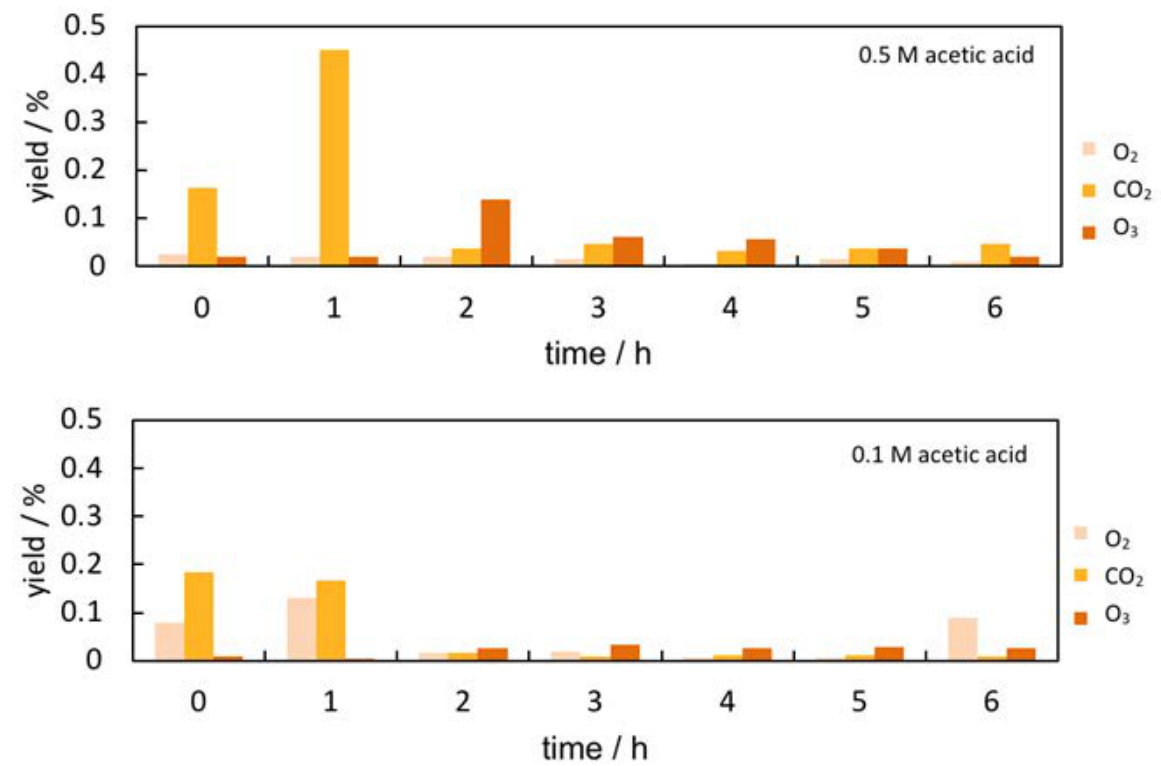
Figure 2. Yield of collagen extracted from tilapia scales using different acetic acid concentrations and gases. Yields were calculated using Equation (1), with concentration values obtained by the Sirius Red